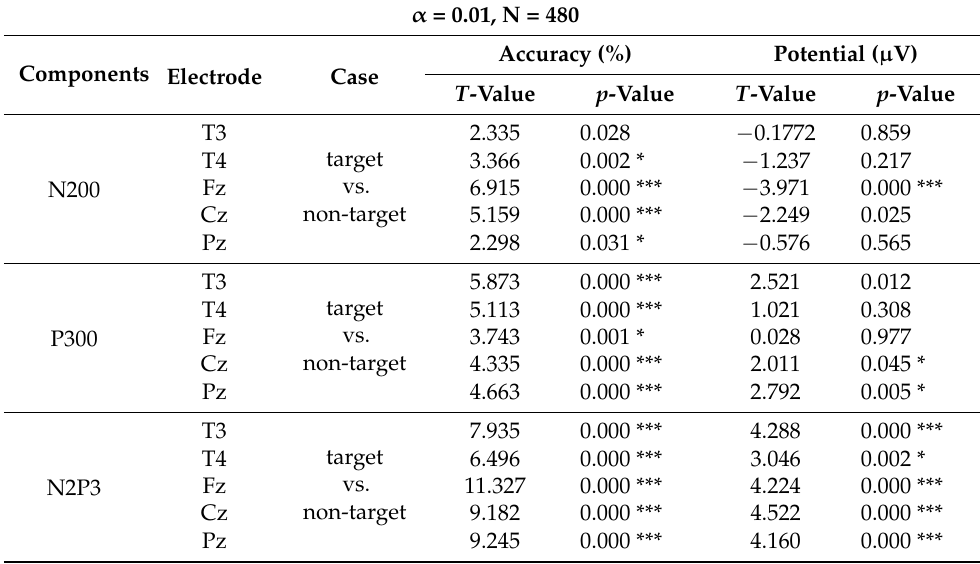
Table 5. Paired samples t -test results of all trials between the target and non-target options regarding accuracy and